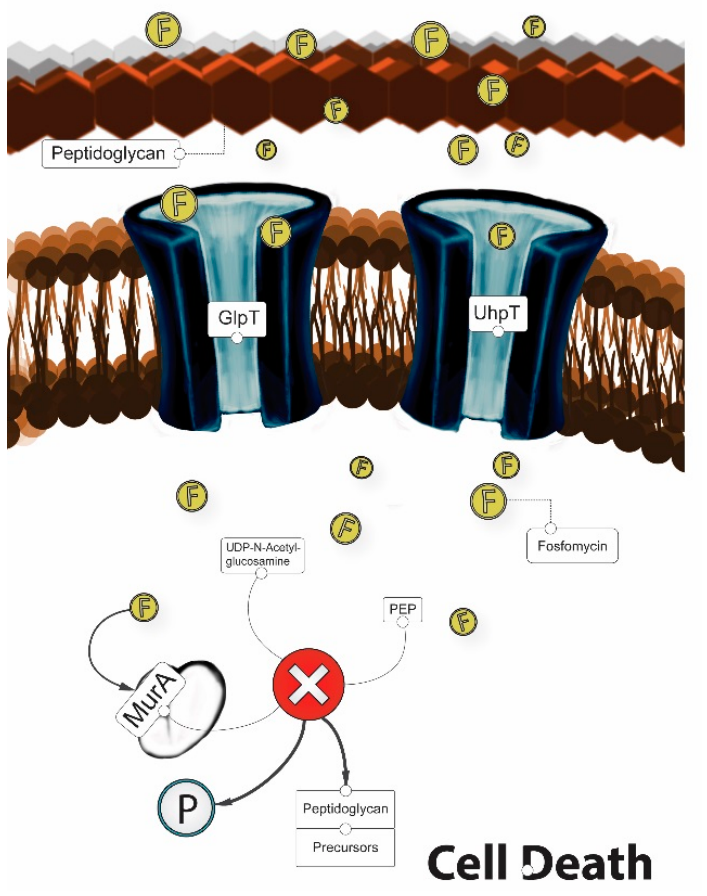
Figure 3. Mechanism of action of fosfomycin (“F”).